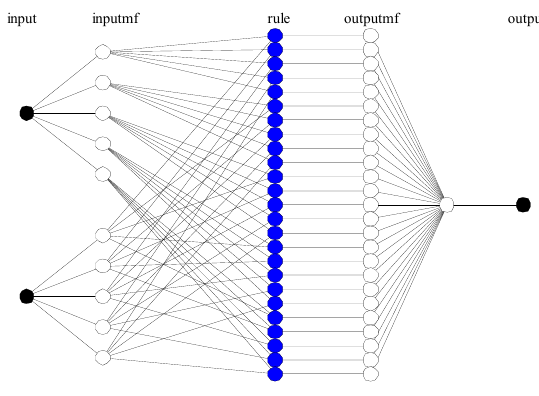
Fig. 4. The structure of the ANFIS with 2 inputs, 5 MFs for each input and 25